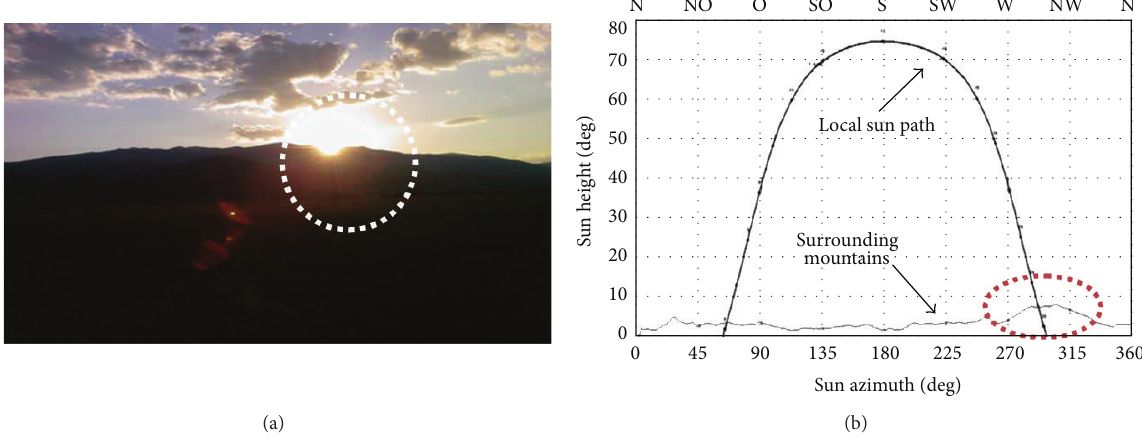
Figure 11: An analysis for application day. (a) A picture from the selected area; (b) recorded data of surrounding mountains combined with local sun path from developed software.